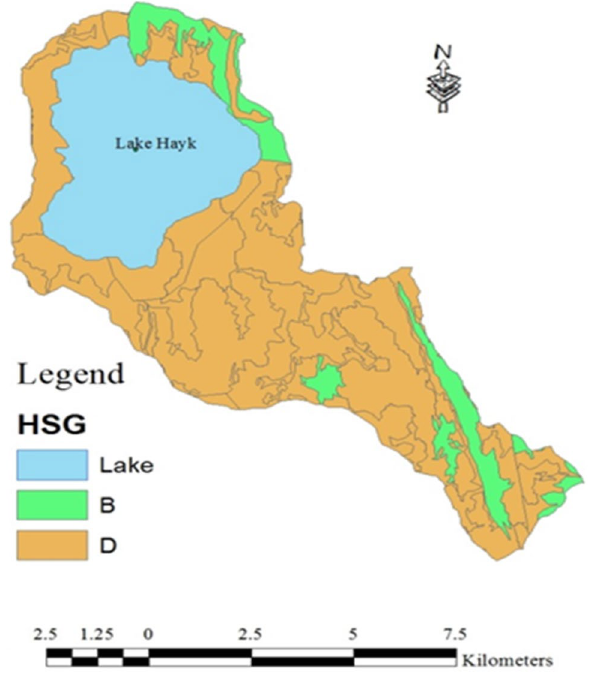
Fig. 5 HSG classes of Hayk Lake